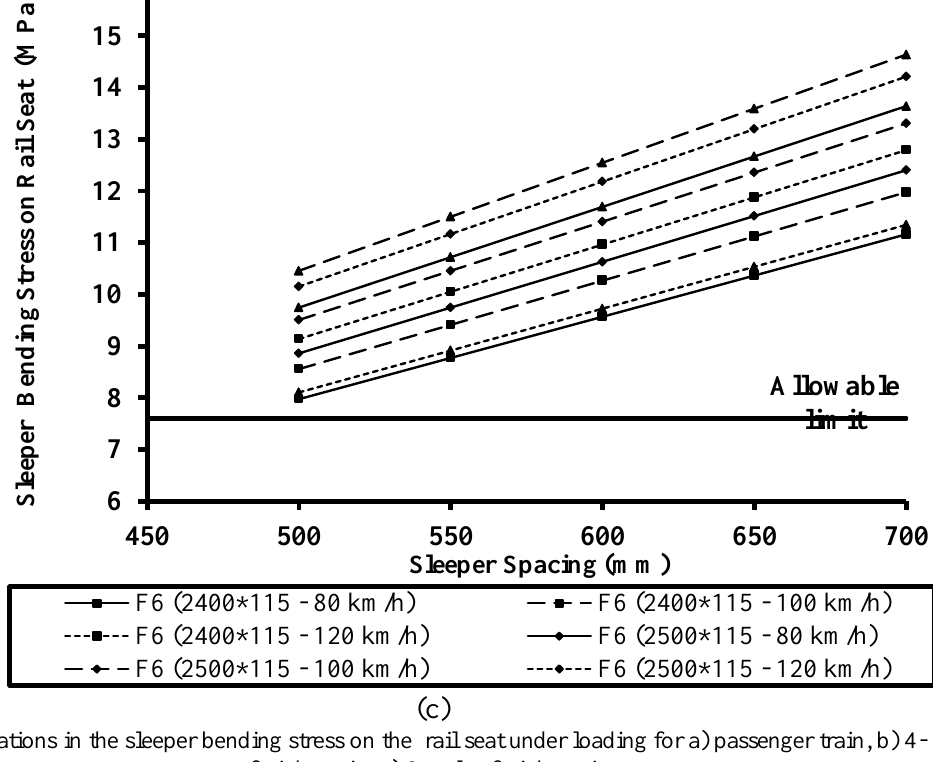
Fig. 9. Variations in the sleeper bending stress on the rail seat under loading for a) passenger train, b) 4- axles freight train, c) 6- axles freight